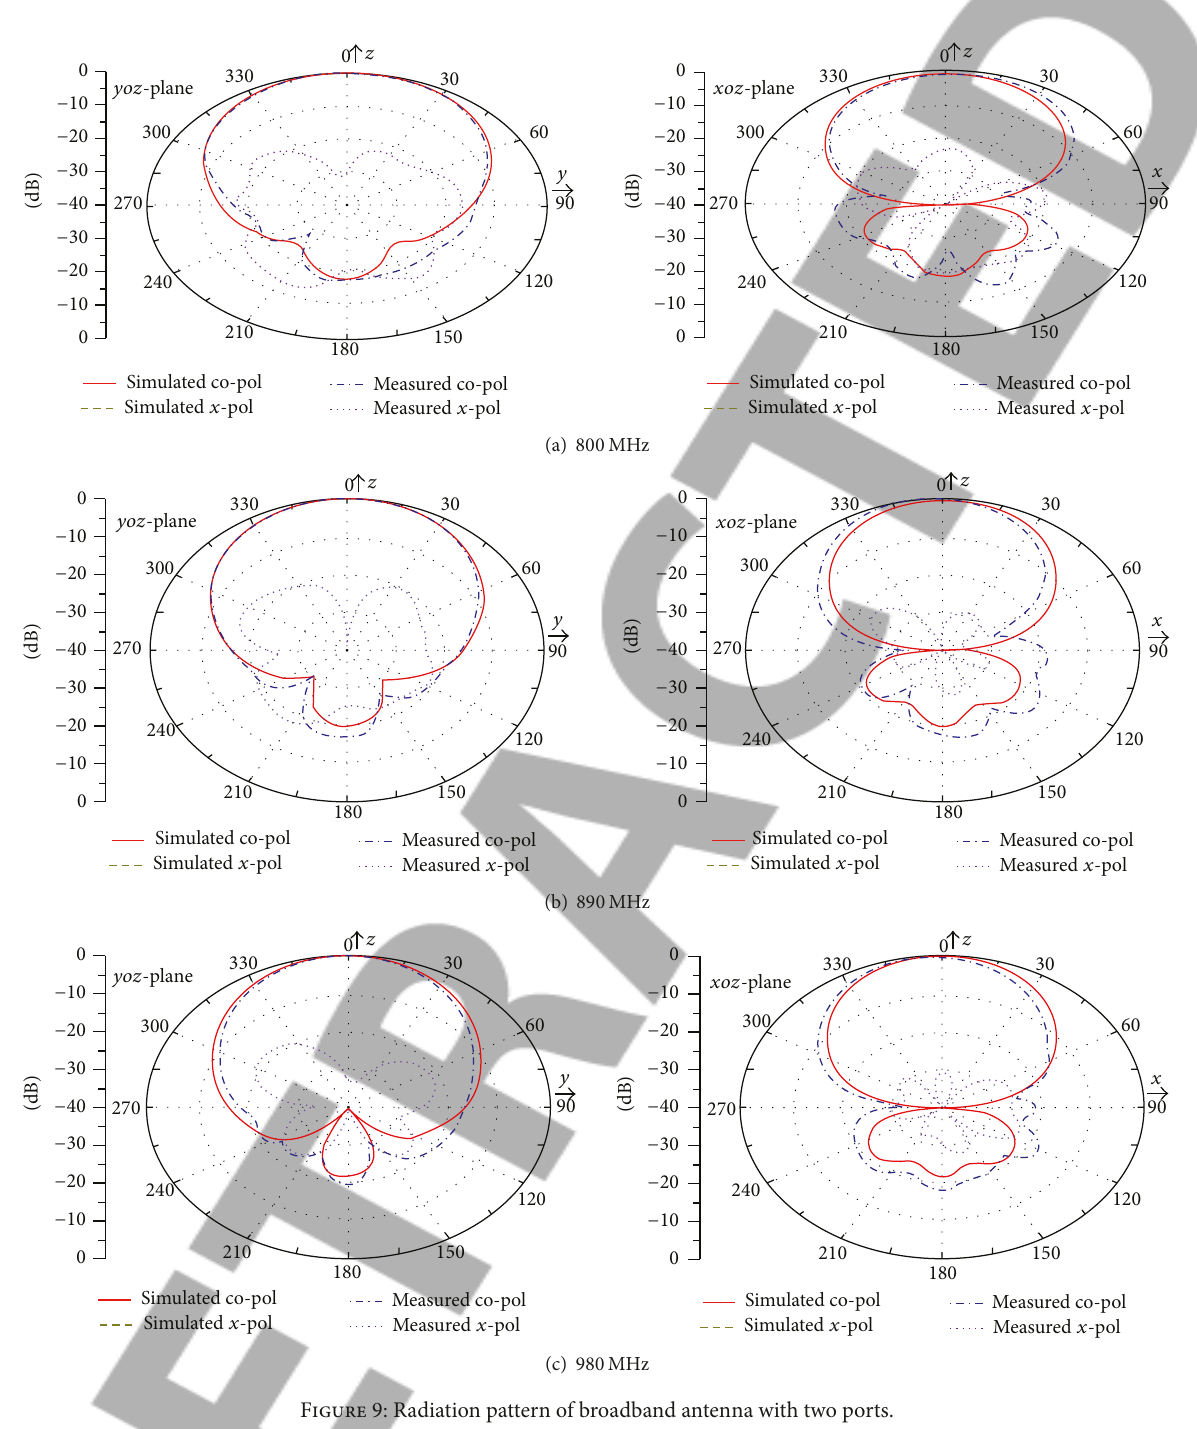
Figure 9: Radiation pattern of broadband antenna with two